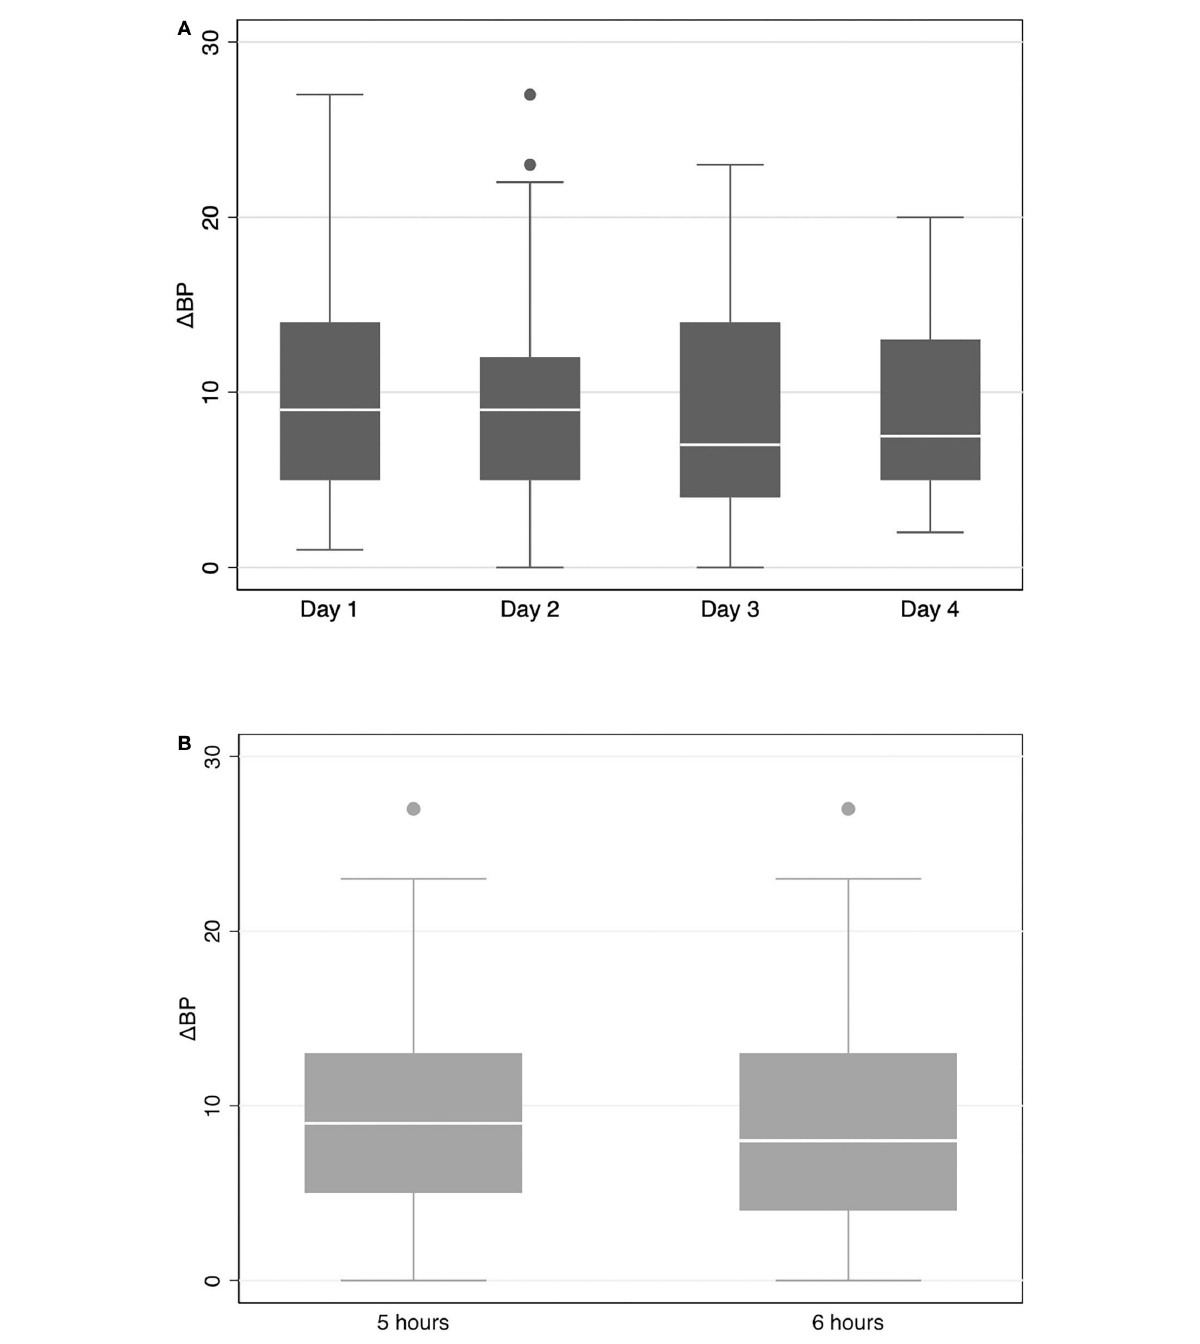
FIGURE2 Box plot of the variation of changes in blood pressure ( 1 BP) among nurses in negative pressure isolation ward (NPIW) [ (A) stratified by working day; (B) stratified by working hours].